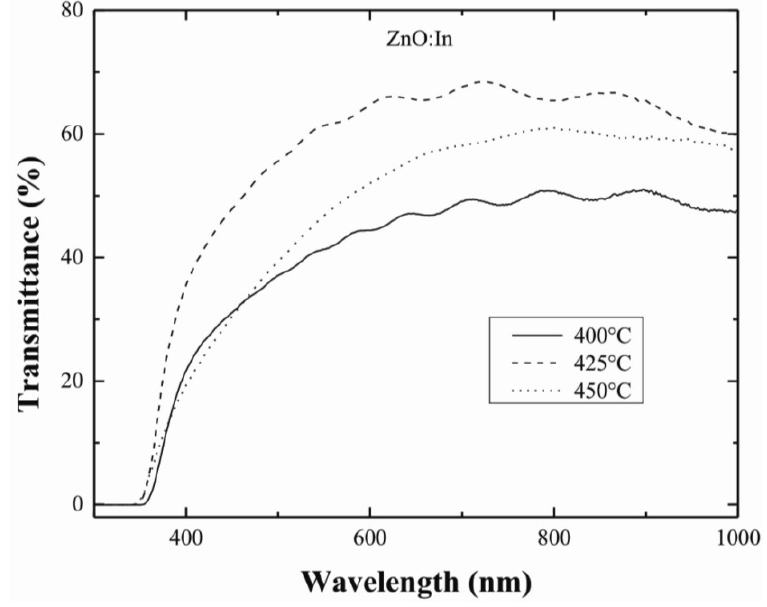
Figure 3. Optical transmittance spectra of ZnO:In thin films deposited at different substrate temperatures for a fixed [In]/[In+Zn] ratio of 3.0